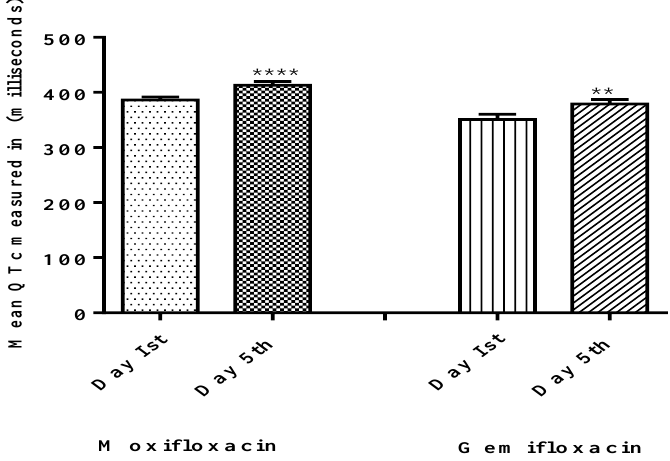
Figure 2. Comparisons of QTc on baseline day one (Pre-dosing) and after dosing day five (Post-dosing) in both groups. Significant differences in QTc in the moxifloxacin-treated group were noted and gemifloxacin was compared on day one and day five. **** shows that p < 0.0001 which shows high level of significance by Moxifloxacin as compared to Gemifloxacin ** p < 0.05. There was one case in the moxifloxacin group ( n = 1) where the QTc was within the